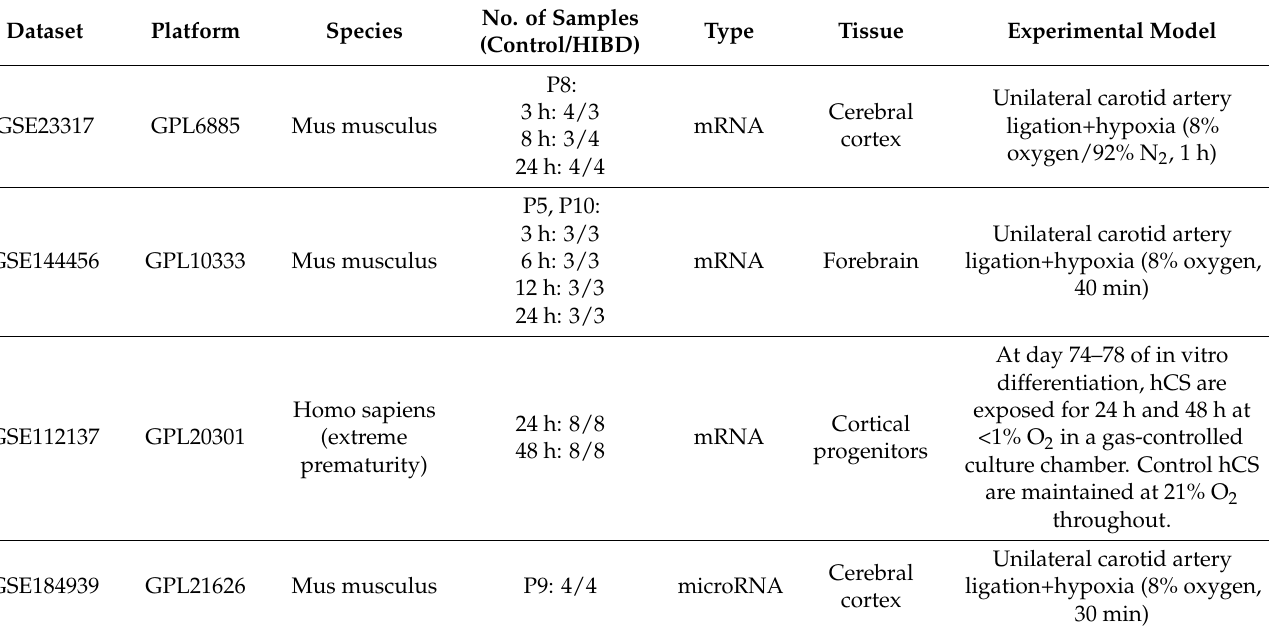
Table 1. The detailed characteristics of the